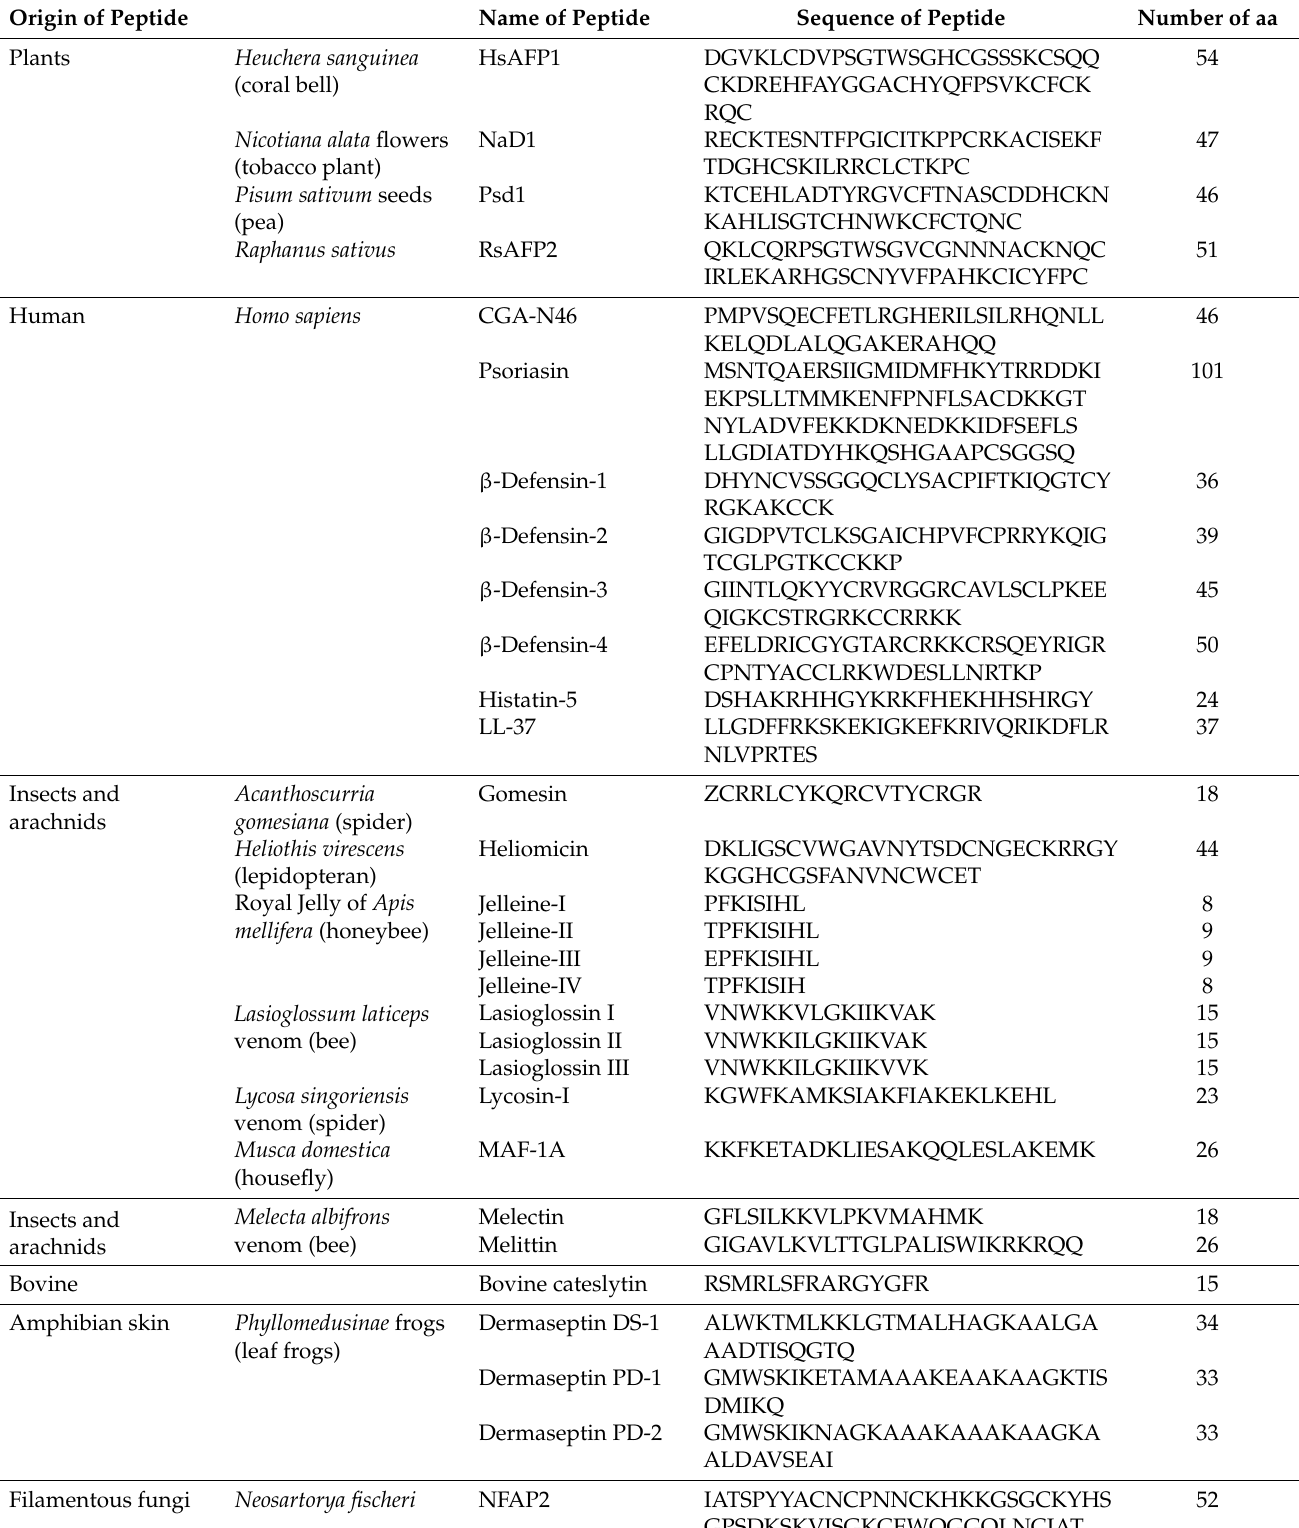
Table 1. Antimicrobial peptides with potential activity against Candida